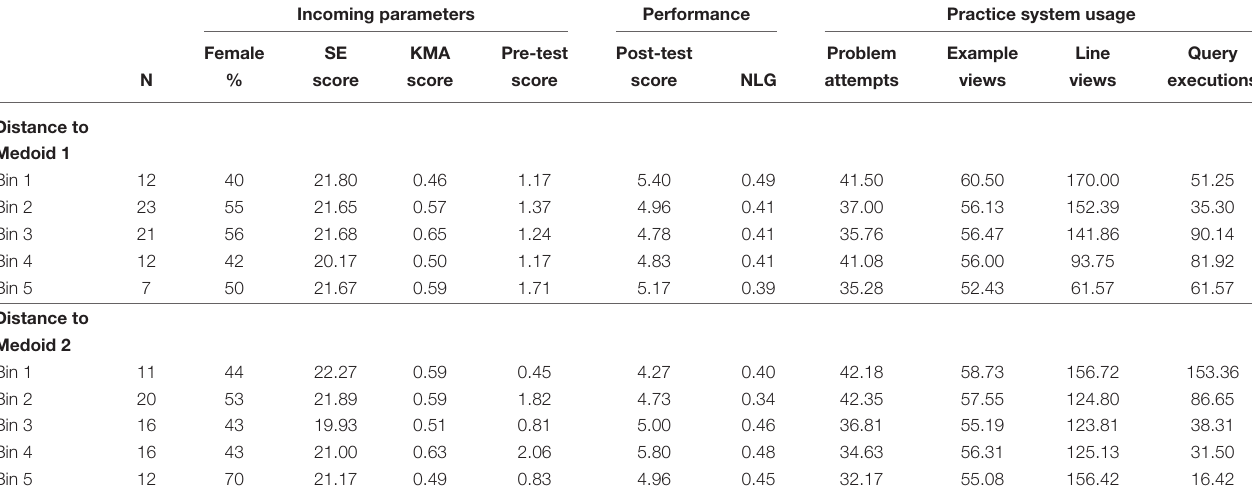
TABLE 7 | Summary of groups obtained by dividing students into five bins based on the Euclidean distances to the two cluster medoids on 2D dimension. Incoming parameters